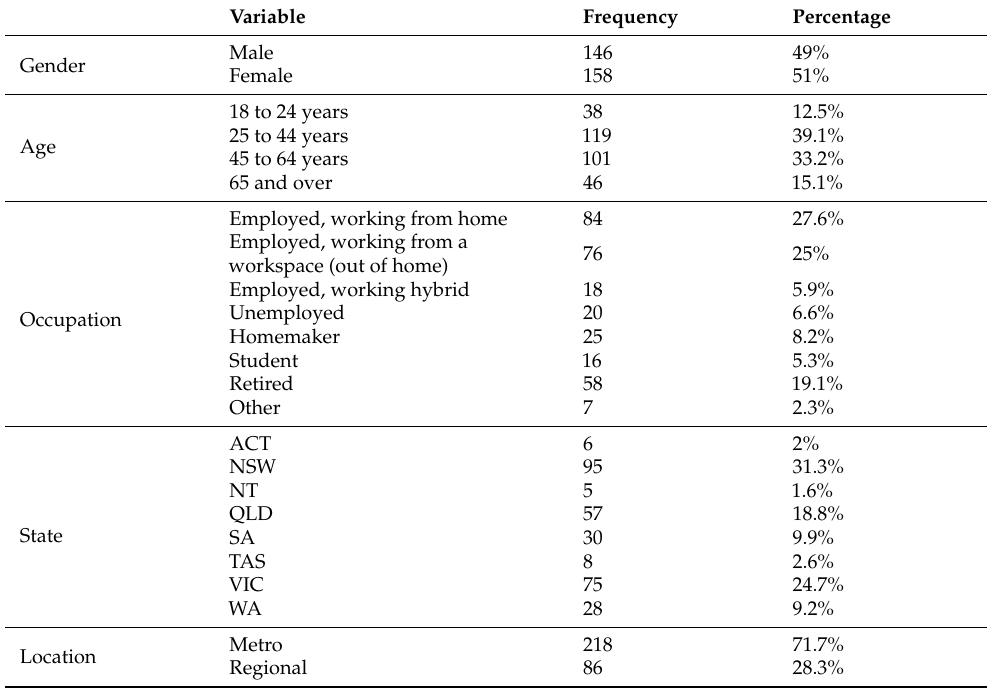
Table 4. Demographic characteristics of the